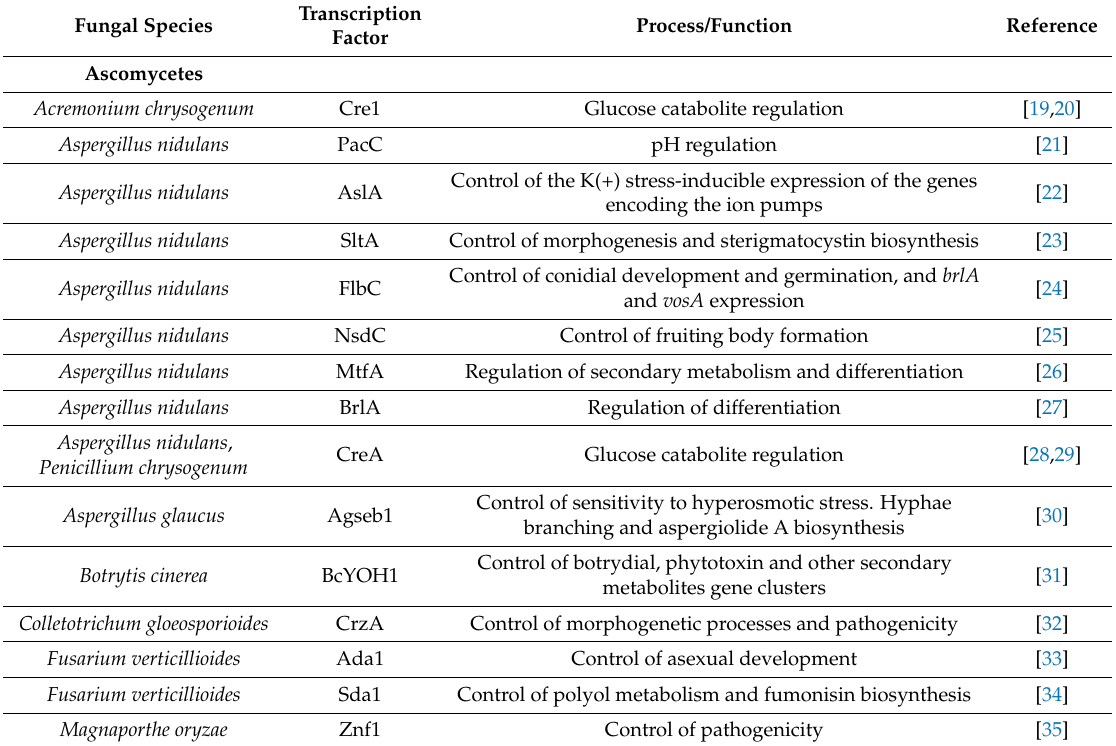
Table 1. Representative examples of class I zinc-binding transcription factors (C 2 H 2 ) that have been characterized in filamentous